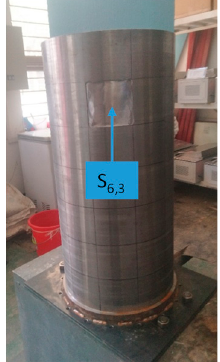
Figure 17. Acceleration sensor installation.